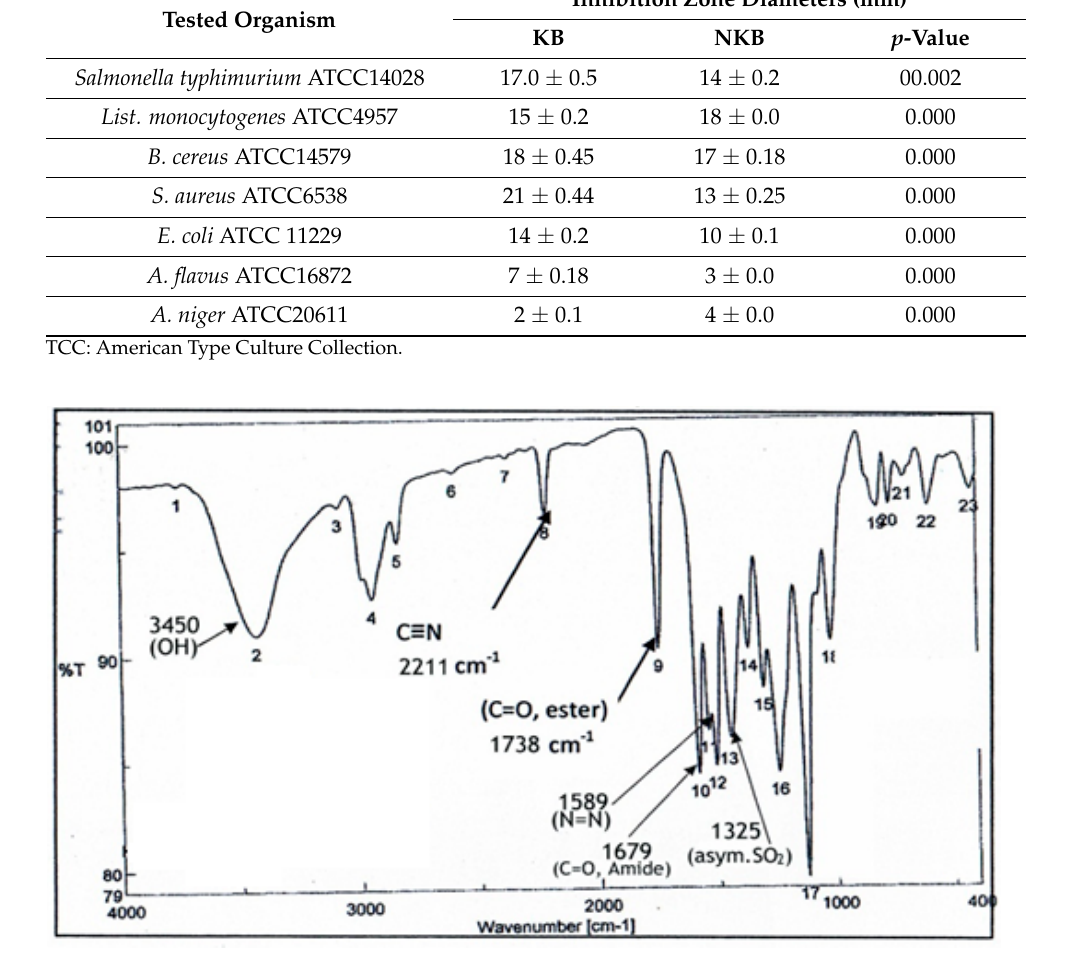
Table 2. Antimicrobial activity of kefir beverage (KB) and neutralized kefir (NKB). Tested Organism